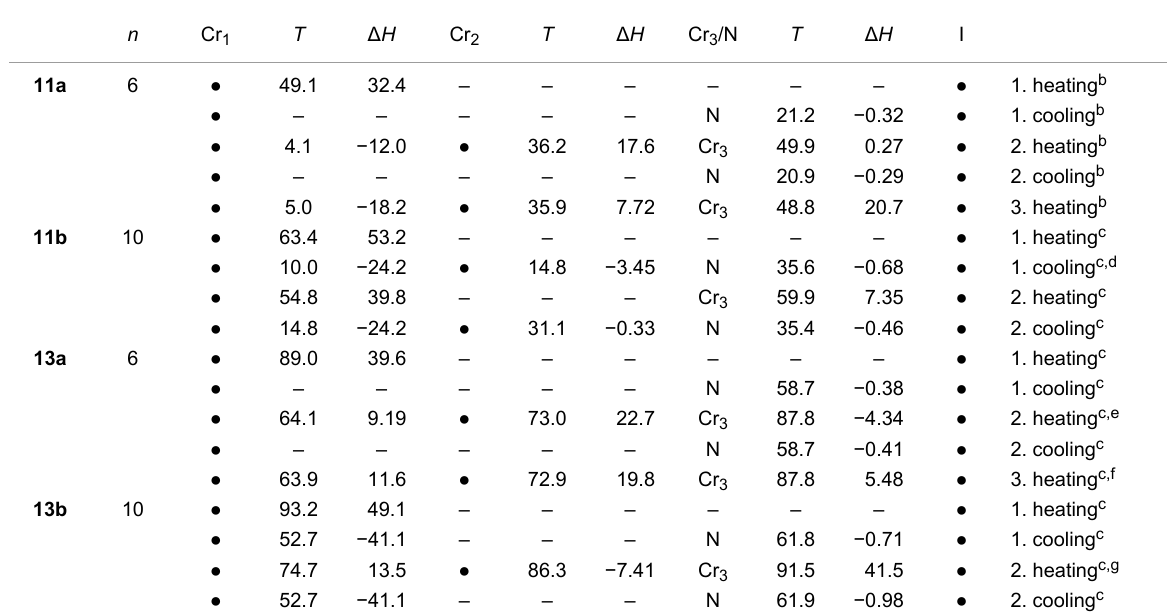
Table 1: Phase-transition temperatures [°C] and enthalpies [kJ/mol] of 11 and 13 . a